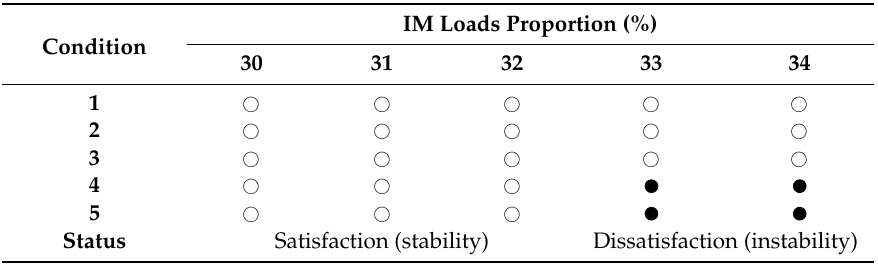
Table 5. Voltage stability condition satisfaction status after the load shedding.